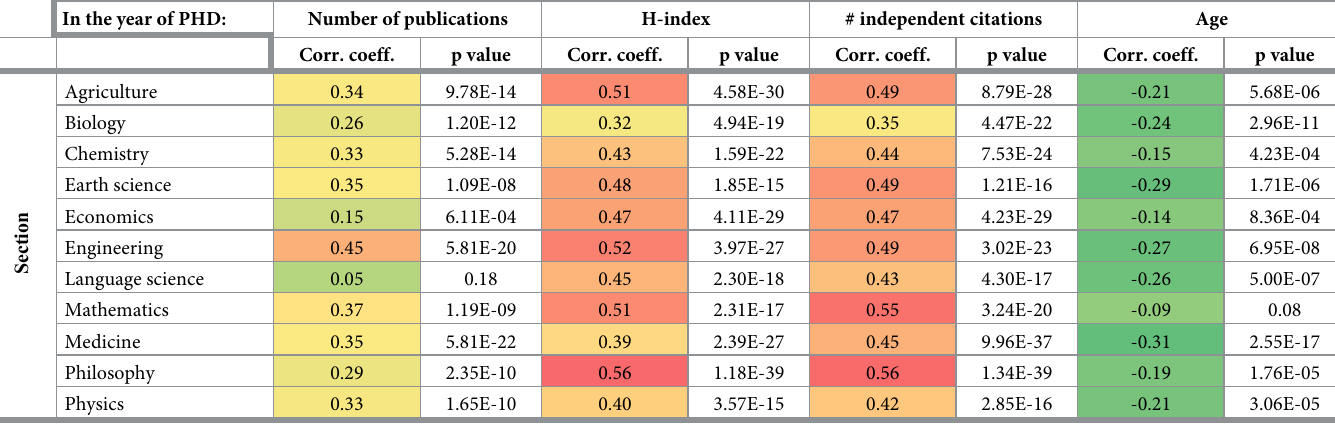
Table 2. Correlation between H-index ten years after obtaining the PhD degree. In the year of